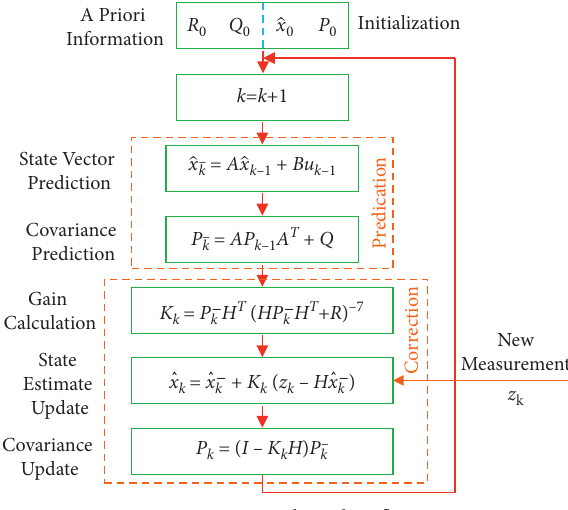
Figure 3: KF algorithm